Question: Provide a one-line summary of what is displayed.
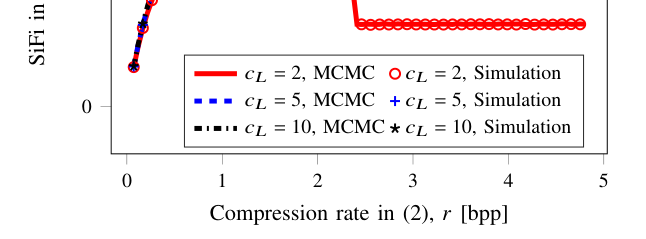
Answer: SiFi in (13) against the compression rate 𝑟in [bpp]. ‘MCMC’ refers to the approximation of the expected SiFi in (20), while ‘Sim- ulation’ refers to the one obtained by averaging (13). The number of available transmission slots 𝐿is calculated as 𝐿= 𝑐𝐿⌈𝑟max/𝑟⌉, where 𝑟max = 4.86 is the average bpp for the PNG compressed images and 𝑐𝐿is a coefficient value [10].